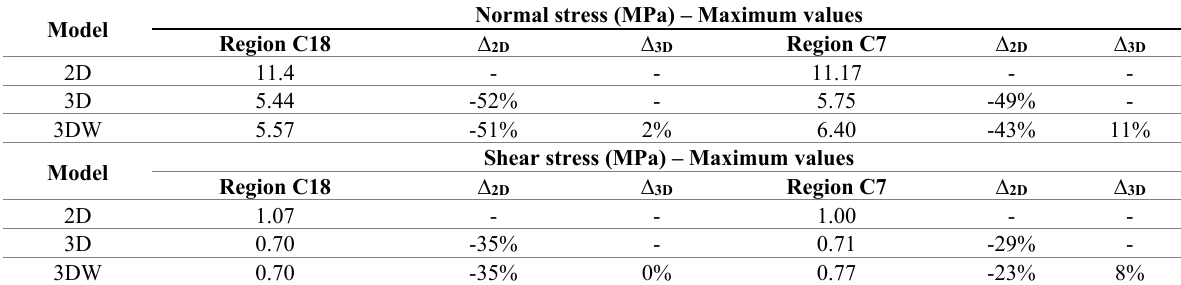
Table 9. Normal and shear stress at the bottom of Wall